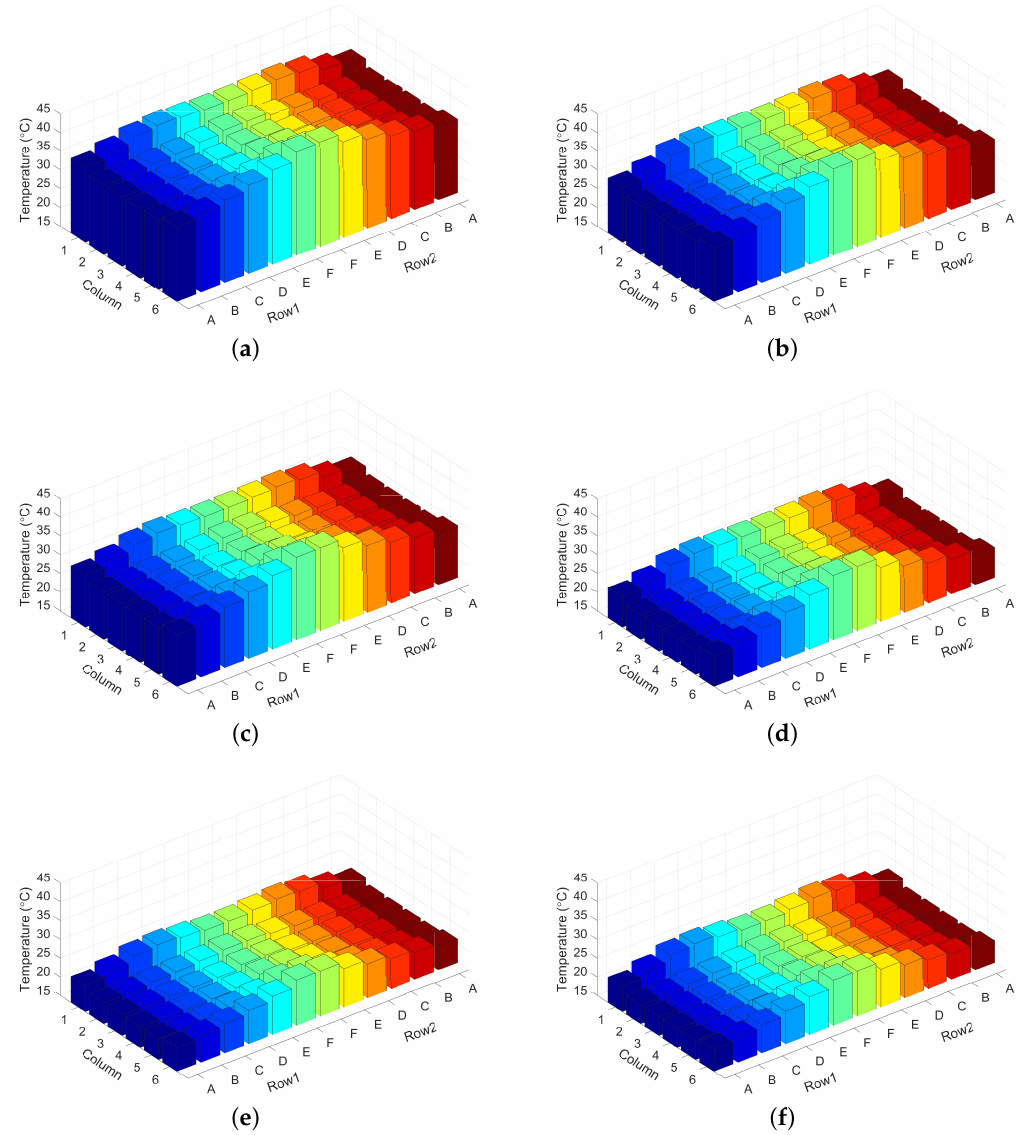
Figure 8. Inlet temperature distribution achieved by different methods. ( a ) Inlet temperature distribution of chip temperature-based workload allocation strategy (CTWA-MTP) with 60% utilization. ( b ) Inlet temperature distribution of CTWA-MTP with 80% utilization. ( c ) Inlet temperature